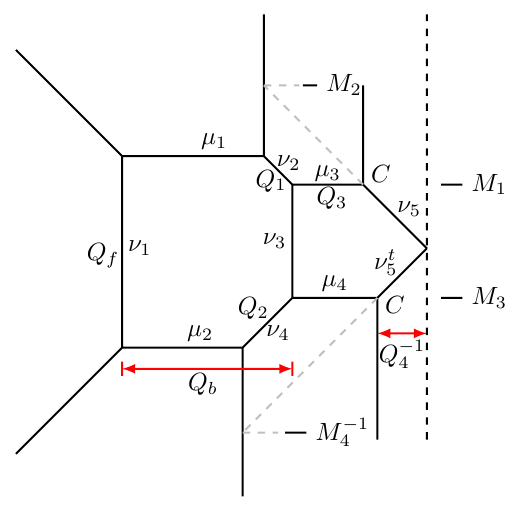
Figure 14 . A 5-brane web for SU(2) with 4 flavors by